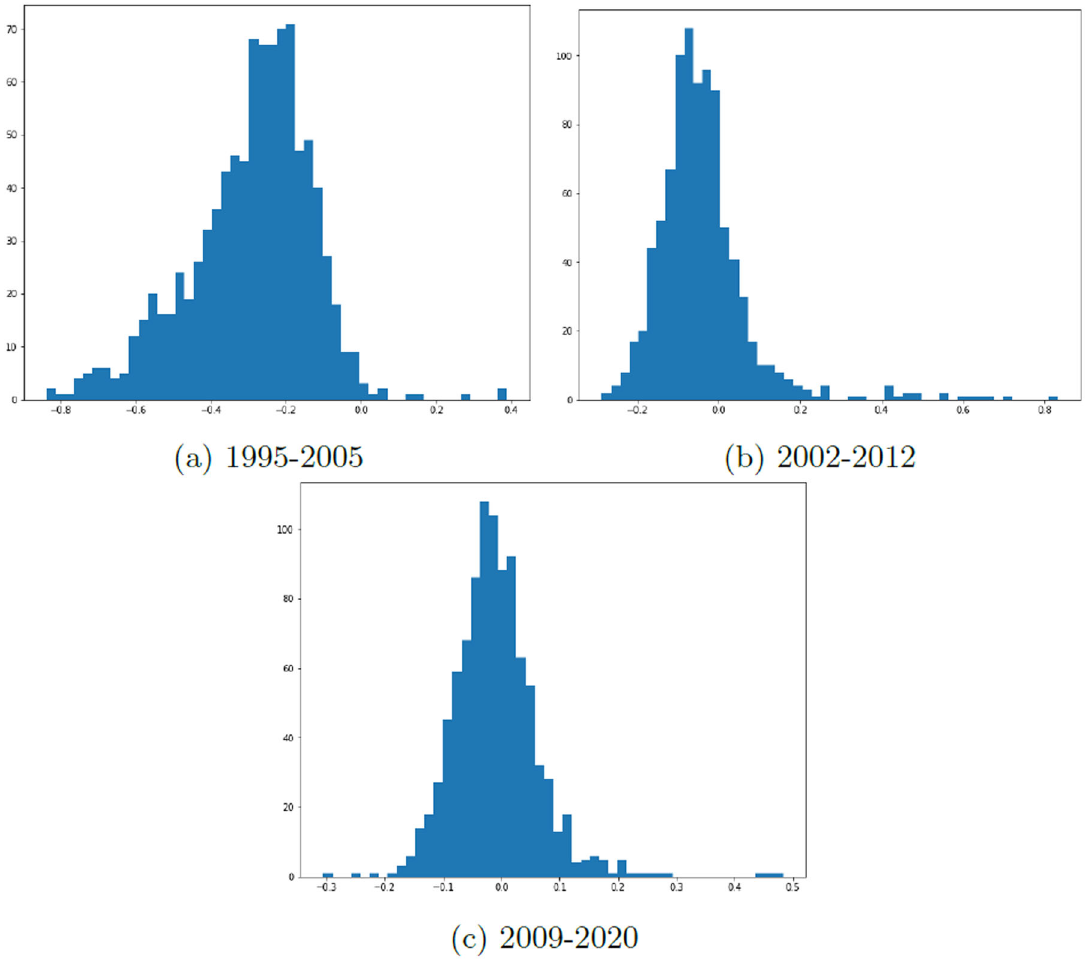
Fig. 6 Histogram of the Sharpe ratio difference between unconstrained and constrained portfolios for 10-year samples. Values less than zero mean that constrained portfolios perform better than unconstrained ones.